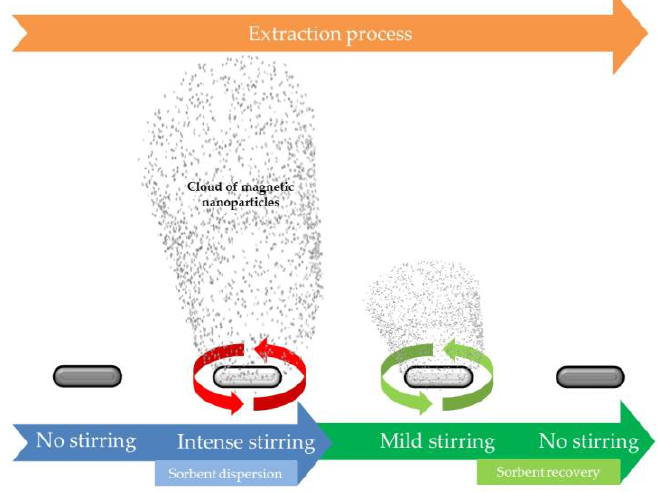
Figure 2. Scheme of stir bar sorptive-dispersive microextraction mediated by magnetic nanoparticles. Reproduced with permission of the Microextraction Tech blog.